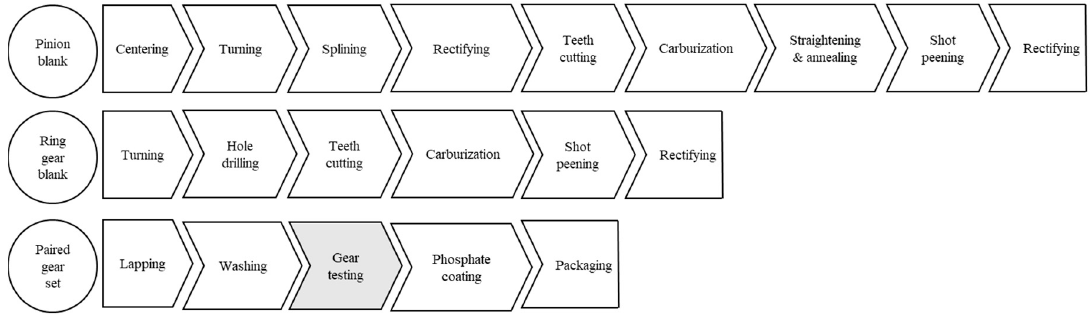
Figure 2. Gear set manufacturing processes.